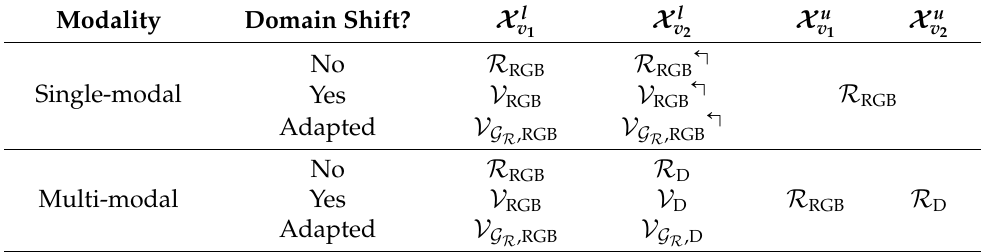
Table 1. The different configurations that we consider for Algorithms 1 in this paper, according to the input datasets. In the single-modal cases, we work only with RGB images (appearance), either from a real-world dataset ( R RGB ), or a virtual-world one ( V RGB ), or a virtual-to-real domain-adapted one ( V G ), i.e., using a GAN-based V RGB Ñ R RGB image translation. One view of the data ( v 1 ) R ,RGB corresponds to the original RGB images of each set, while the other view ( v 2 ) corresponds to their horizontally mirrored counterparts, indicated with the symbol “ è ”. In the multi-modal cases, view v 1 is the same as for the single-modal case (RGB), while view v 2 corresponds to the depth (D) estimated from the RGB images by using an off-the-shelf monocular depth estimation